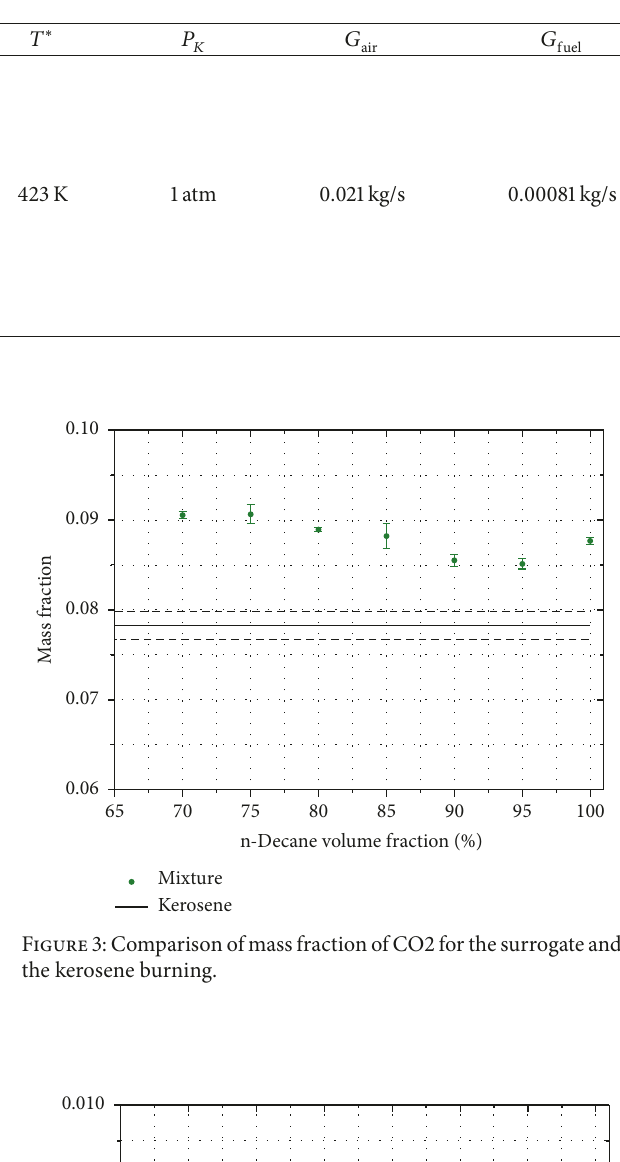
Table 2: Experimental case.